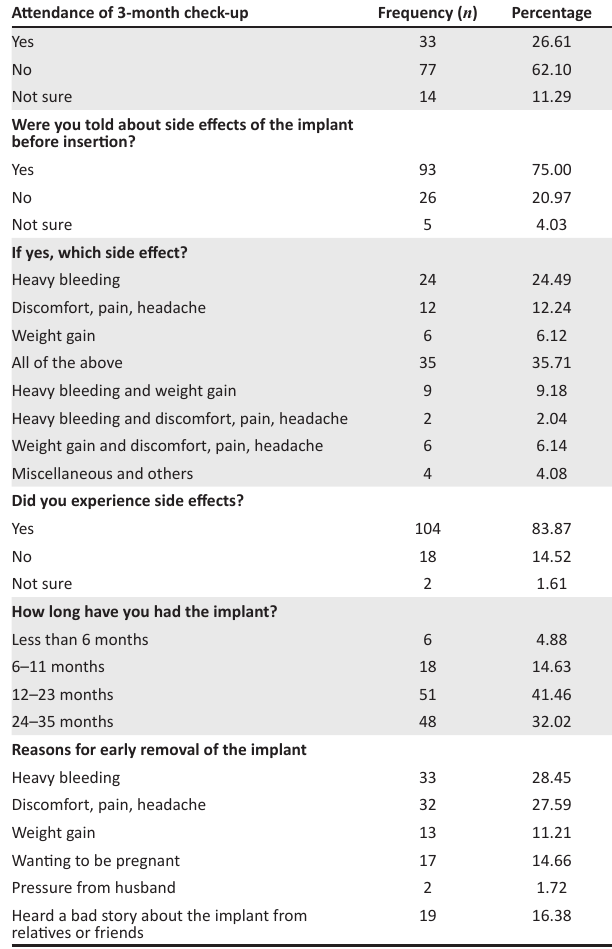
TABLE 2: Pre-insertion health status of participants. Assessment elements